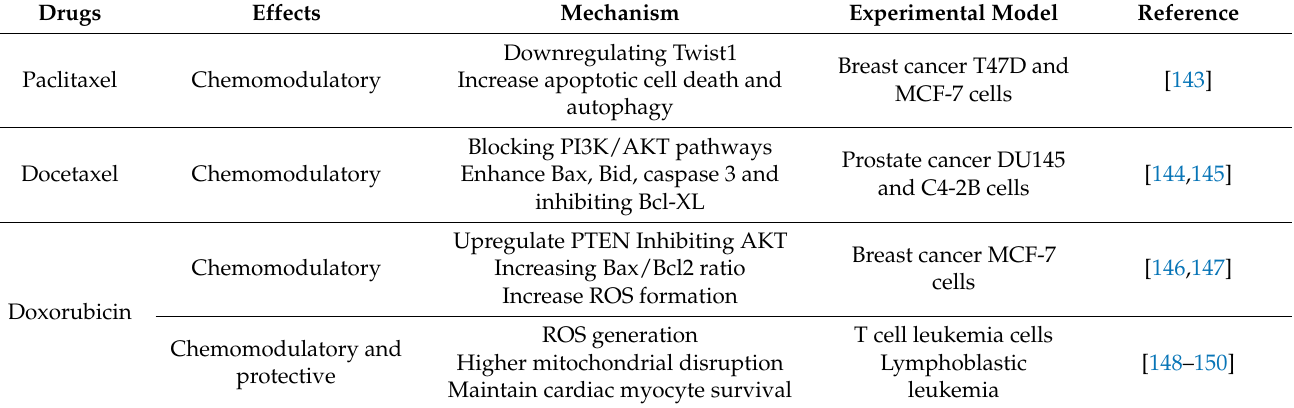
Table 3. The chemomodulatory/chemosensitizing and protective effects of thymoquinone in combination with chemothera- peutic